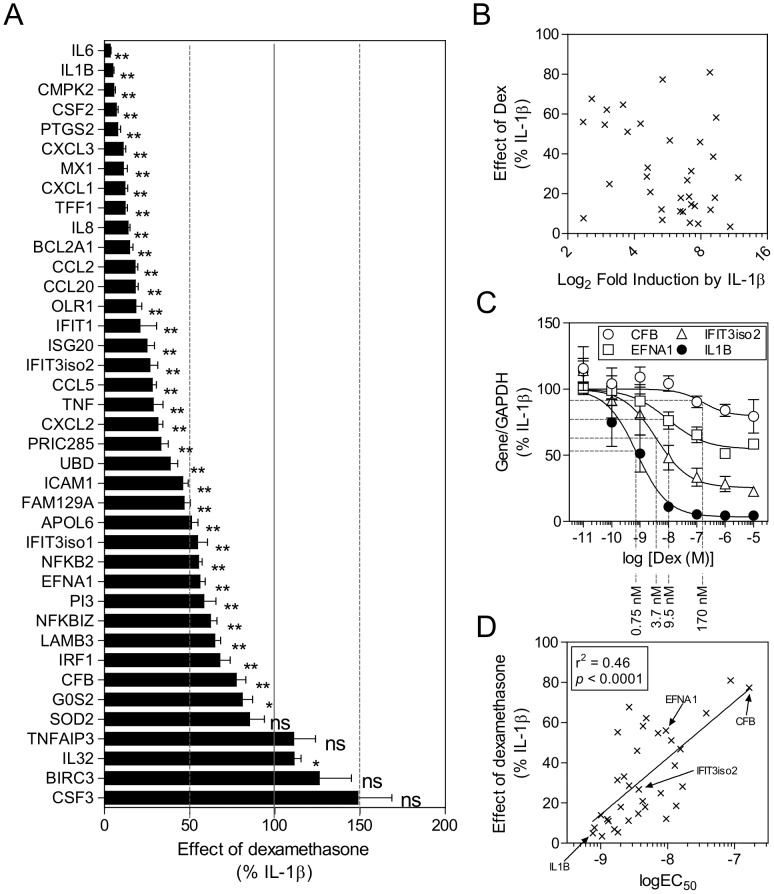
Effect of dexamethasone on inflammatory gene expression.
A. The effect of dexamethasone (1 µM) is shown on the induction of inflammatory genes by IL-1β (1 ng/ml) at 6 h. Data from Figures S2 and S3 were combined and the effect of dexamethasone expressed as a percentage of IL-1β for each gene. 100% indicates no effect of dexamethasone. Data (n = 9) are plotted as means ± SE. Genes are listed by descending efficacy to repression by dexamethasone. Statistical analysis was performed by non-parametric paired t-test. * P<0.05; ** P<0.01. B. Relationship between induction by IL-1β and repression by dexamethasone. The effect of dexamethasone (1 µM) expressed as a percentage of IL-1β is plotted against the fold induction of each gene. Data are derived from Figure 2A and Figure S2. Linear regression was performed using GraphPad Prizm software. C. Repression by dexamethasone is shown for the most highly sensitive gene (IL-1β), two genes showing intermediate sensitivity (EFNA1 & IFIT3 isoform 2) and the lowest sensitivity gene (CFB) (that showed significant repression by 1 µM dexamethasone). Actual EC50 values are indicated. D. Relationship between the effect of 1 µM dexamethasone (efficacy) and the sensitivity (log EC50) of the repression by dexamethasone for individual genes. The effect of dexamethasone (1 µM) expressed as percentage of IL-1β is plotted against the log EC50 for the repression of each gene. Data are derived from Figure 2A and Figure S3 respectively. Linear regression was performed using GraphPad Prizm software.